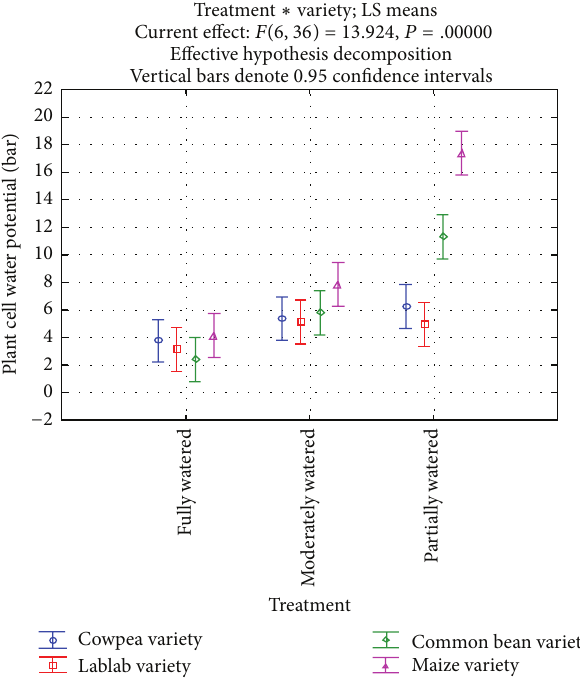
Figure 4: Plant cell water potential of P. vulgaris, V. unguiculata , L. purpureus , and Z. mays under different treatments in experiment 1.